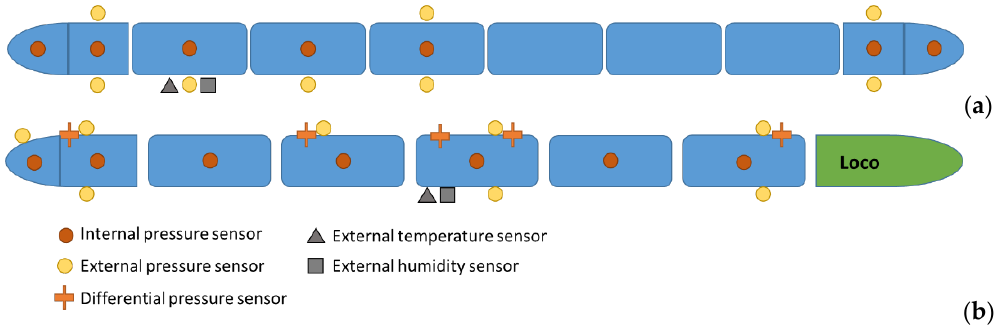
Figure 10. Schematic visualizations of the pressure tap positions along ( a ) the sealed train and ( b ) the unsealed train.